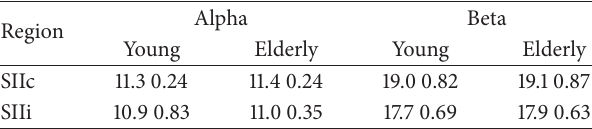
Table 1: Mean (SEM) ERD reactive frequency for alpha and beta